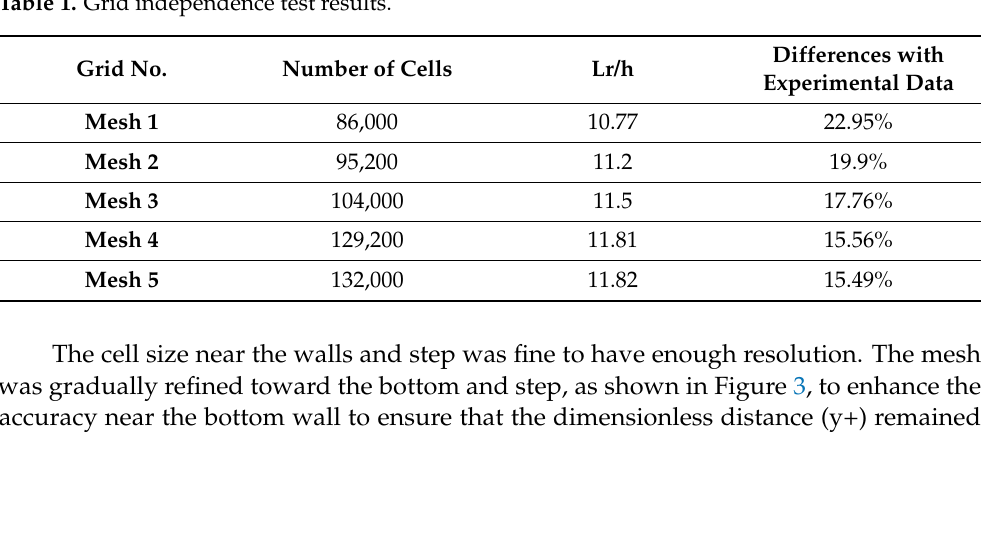
Figure 2. Schema of backward-facing step flow (BFSF) (not to scale).